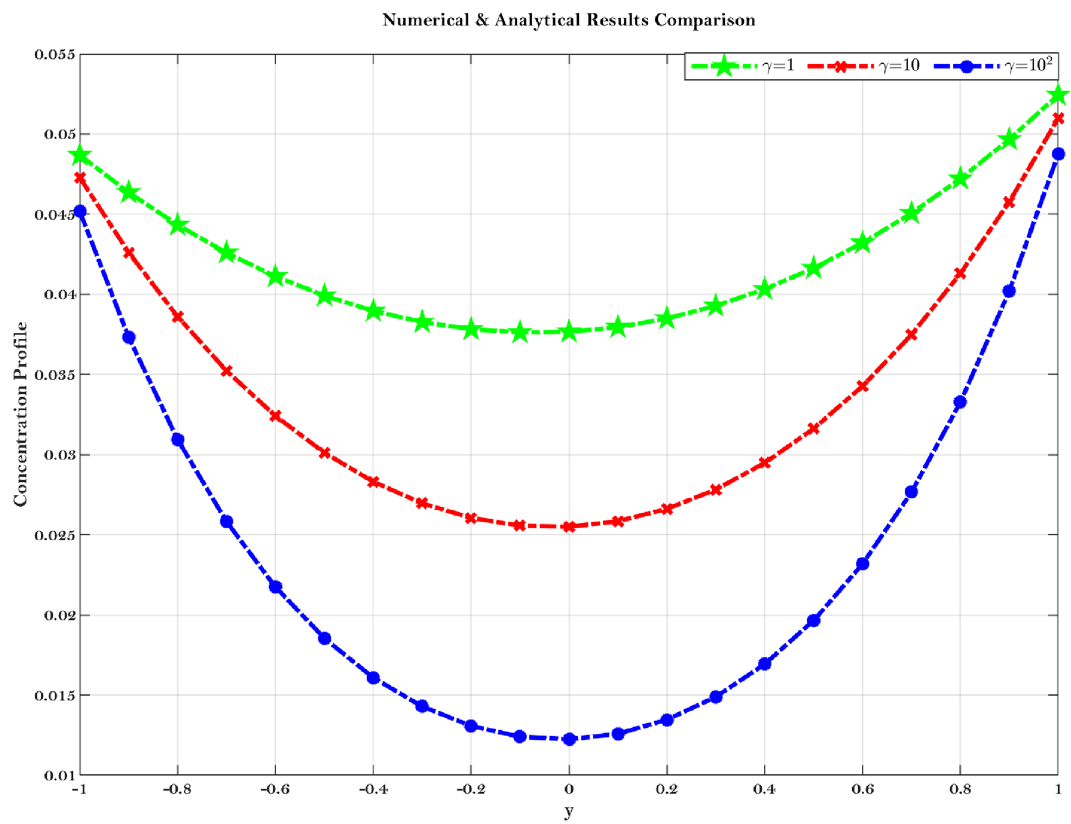
Figure 8. Shows concentration profile comparison at different value of the γ